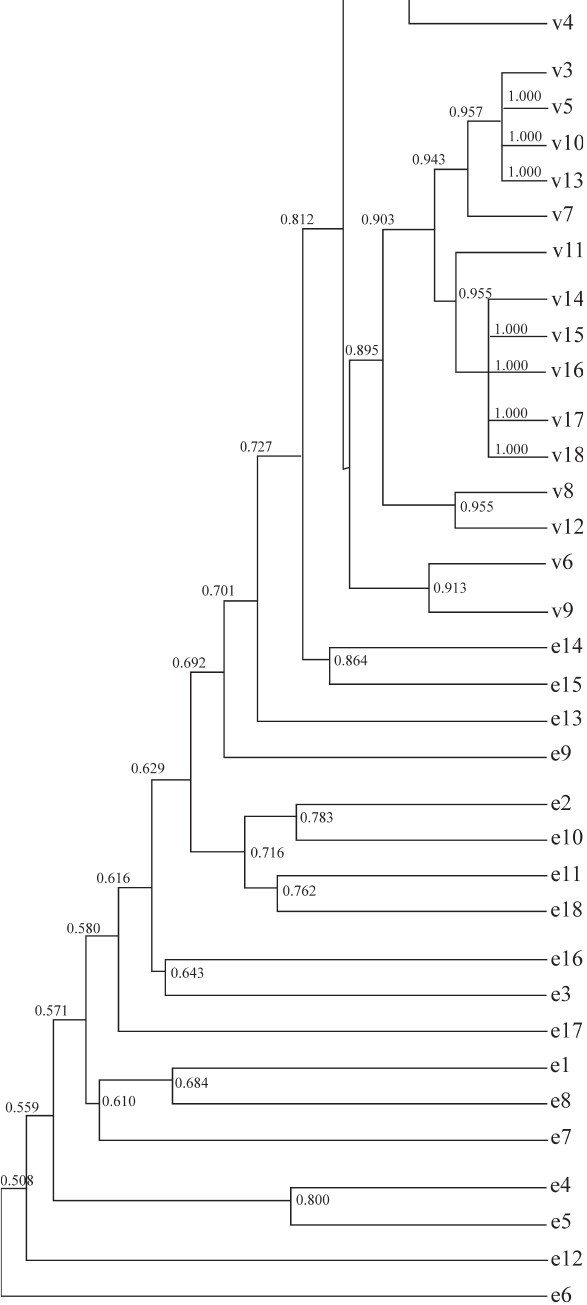
Figure 2 - Dendrogram of genetic similarity for individuals of F 3 Panama (e 1 - e 18 ) and F 17 Venezuela (v 1 - v 18 ) based on the UPGMA method.